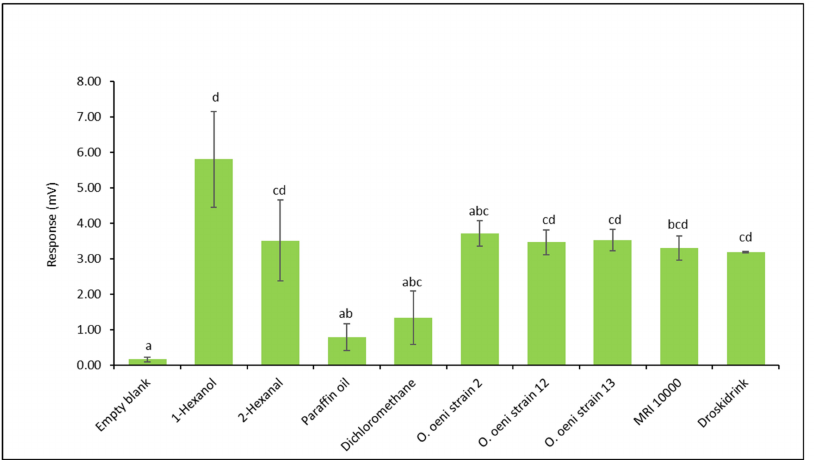
Figure 3. Mean electroantennography (EAG) responses (mV) of D. suzukii mated female antennae elicited by commercial DD and DD inoculated with different O. oeni strain 2, strain 12 and strain 13. Control stimuli: empty blank, paraffin oil, and dichloromethane solvent. Reference compounds: 1-hexanol, 2-hexanal. Baits: commercial DD, O. oeni reference strain (MRI 10000), strain 2, strain 12, and strain 13. The standard deviation of the means is reported. Bars represented by similar letters are significantly indifferent ( p >